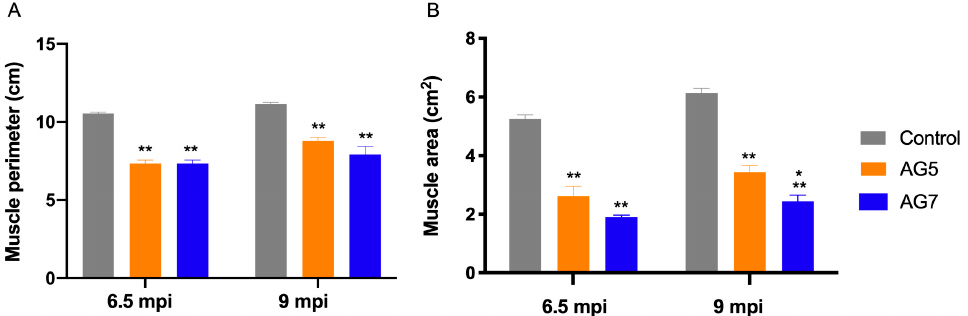
Figure 3. Histogram of the measurements of perimeter ( A ) and area ( B ) of the TA muscle obtained by echographical imaging. Values are mean ± SEM. * p < 0.05 group AG7 vs. AG5; ** p < 0.0001 groups AG7 and AG5 vs. Control.